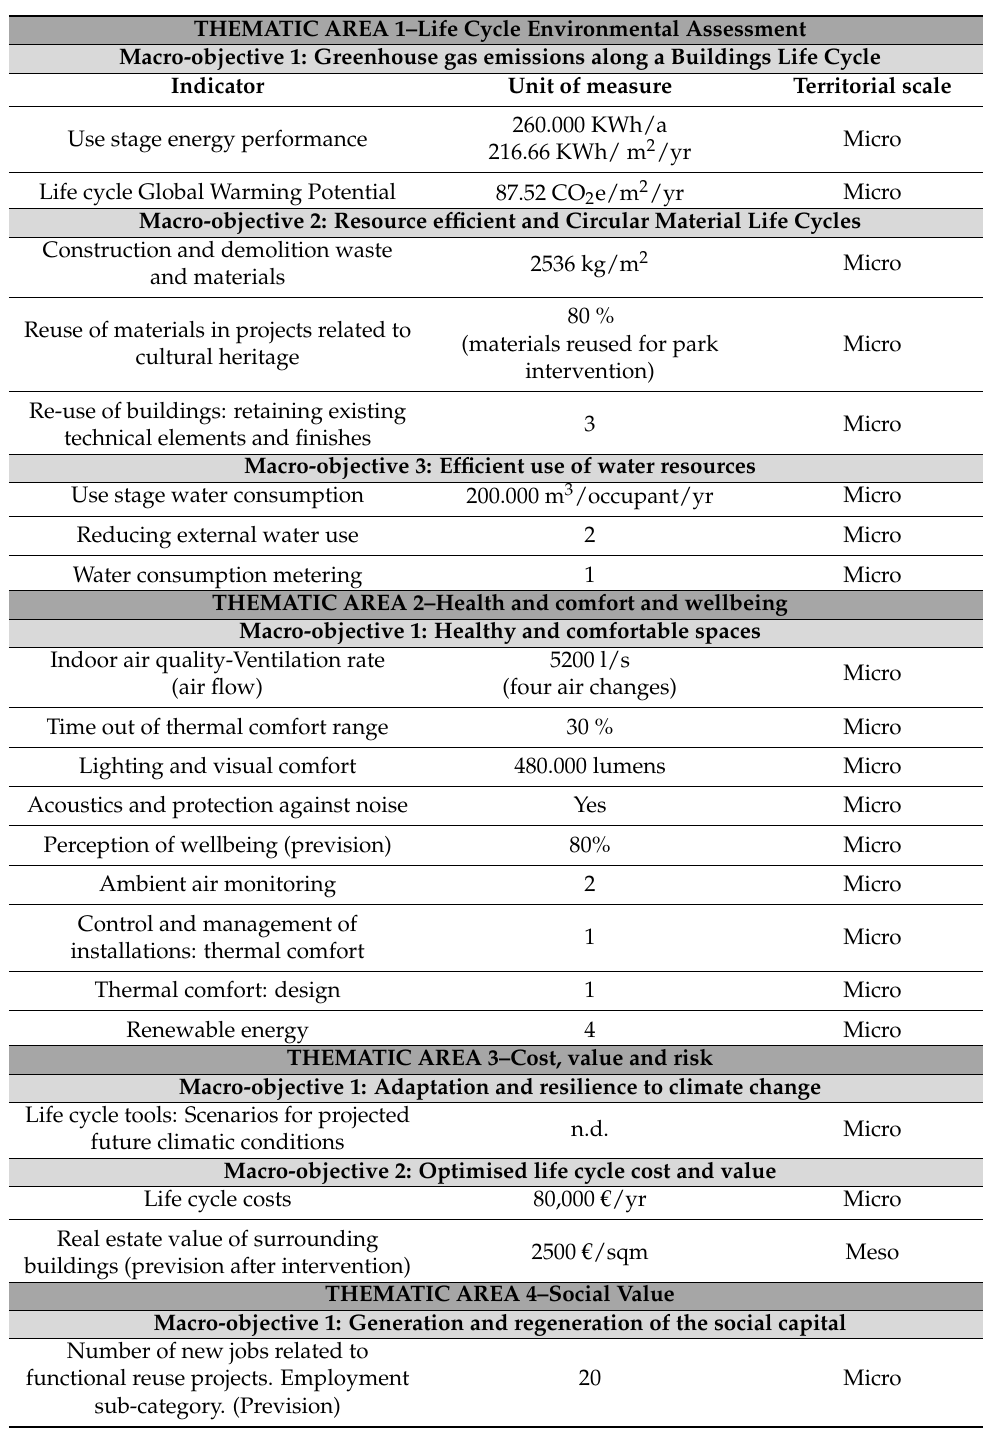
Table 4. CHL(s) applied to Villa Vannucchi renovation/reuse